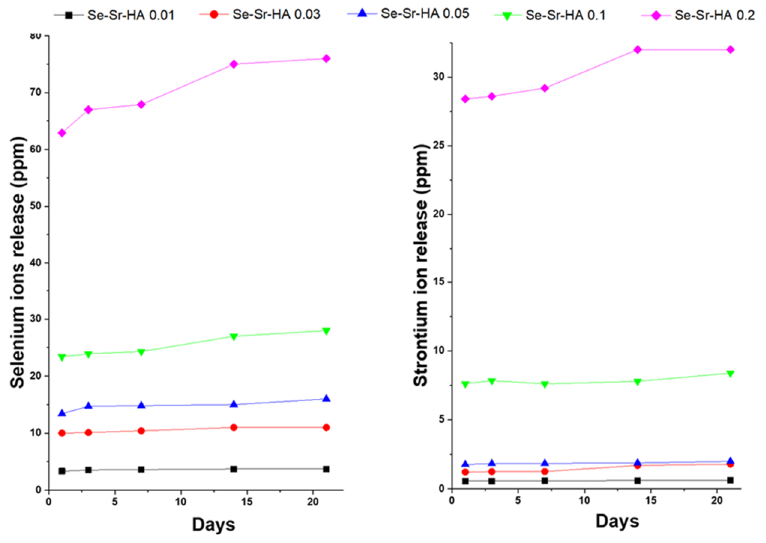
Figure 5. Release profile of strontium and selenium ions from Se-Sr-HA samples immersed in simulated body fluid (SBF) measured by using inductively coupled plasma (ICP-OES).